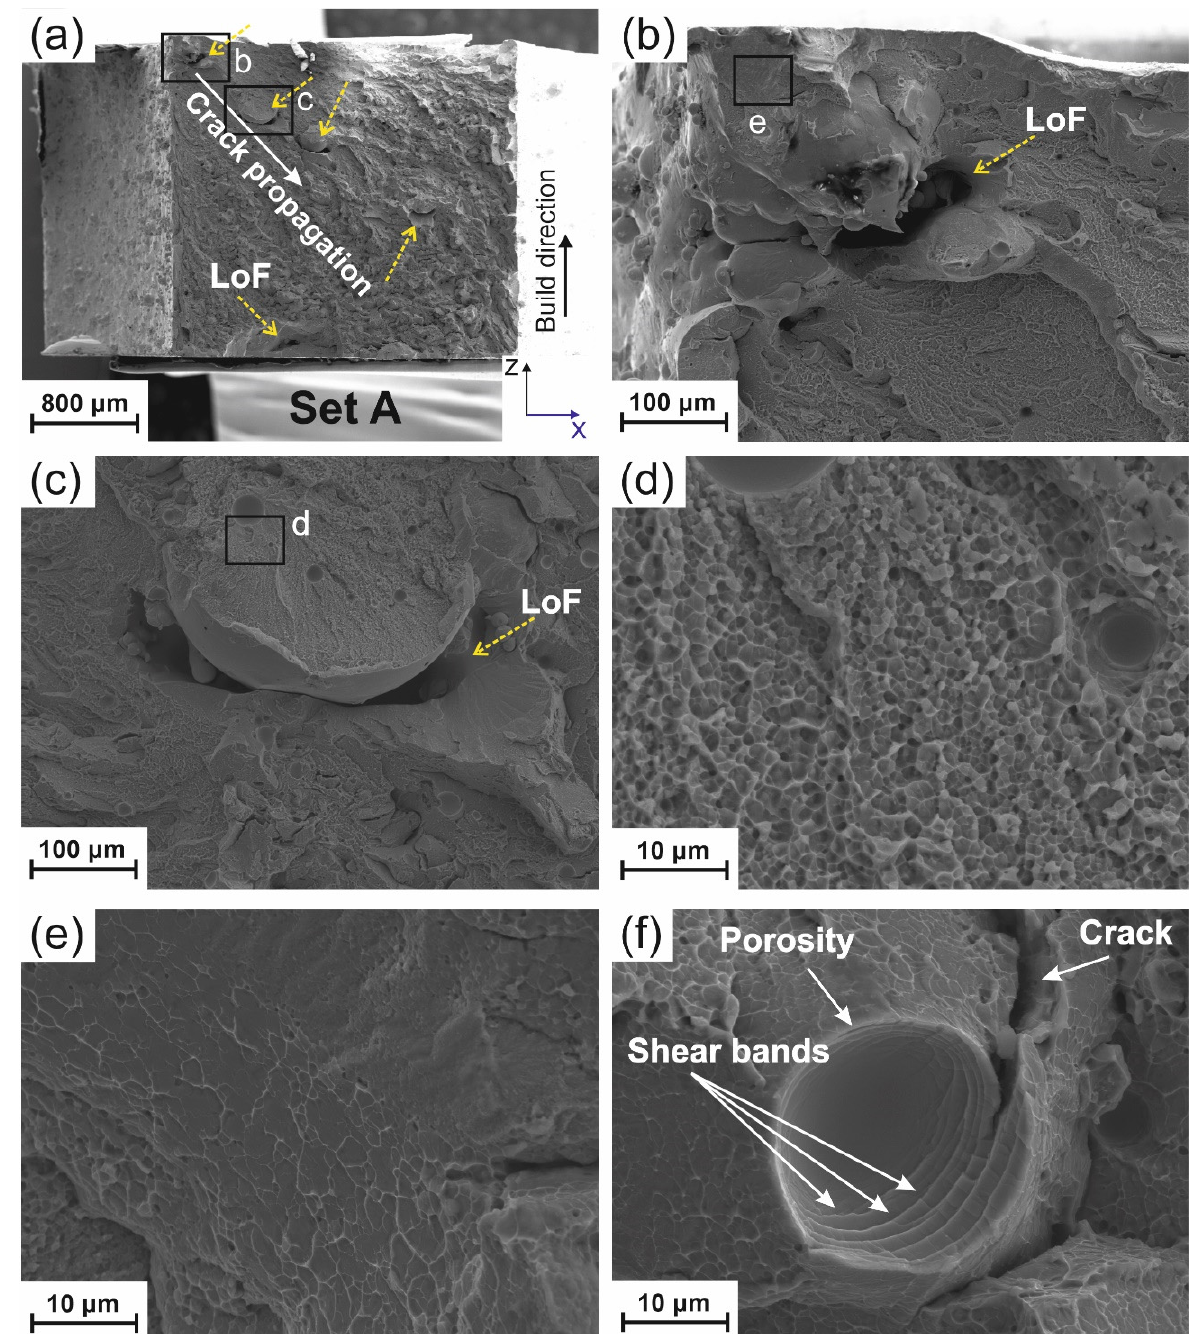
Figure 45. ( a ) Macroscopic fracture surface of a sample fabricated by a chosen Set A of processing parameters in Ref. [78], ( b ) magnified region b in ( a ) showing the location where failure started from a LoF close to the surface, ( c ) magnified region c in ( a ) showing another LoF in the core of the sample, ( d ) magnified region d in ( d ) showing a dimple-like structure, ( e ) magnified region e in ( b ) showing vein-like pattern, which is typical of BMGs, and ( f ) porosity arrests a crack and multiple shear bands are formed.